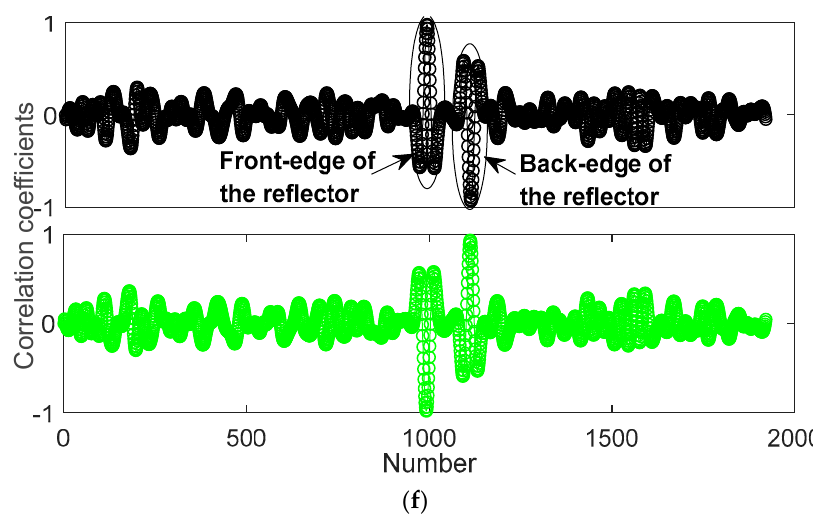
( f ) Figure 8. Numerical signals with different signal-to noise ratios (SNRs) and comparisons of the Figure 8. Numerical signals with di ff erent signal-to noise ratios (SNRs) and comparisons of the results by the proposed method and correlation coe ffi cient method; ( a ) ˆ x 1 ( t ) with SNR = 1 dB; ( b ) Distance results by the proposed method and correlation coefficient method; ( a ) 1 ˆ ( ) x t with SNR = 1 dB; curves Ψ 1 ( Up ) and Ψ 2 ( Down ) of ˆ x 1 ( t ) ; ( c ) ˆ x 2 ( t ) with SNR = 0.1 dB; ( d ) Distance curves Ψ 1 ( Up ) ( b ) Distance curves Ψ 1 ( Up ) and Ψ 2 ( Down ) of 1 ˆ ( ) x t ; ( c ) 2 ˆ ( ) x t with SNR = 0.1 dB; ( d ) Distance and Ψ 2 ( Down ) of ˆ x 2 ( t ) ; ( e ) Pearson’s correlation coe ffi cient method (PCCM) curves Ψ 1 ( Up ) and Ψ 2 curves Ψ 1 ( Up )and Ψ 2 ( Down ) of 2 ˆ ( ) x t ; ( e ) Pearson’s correlation coefficient method (PCCM) ( Down ) of ˆ x 1 ( t ) ; ( f ) PCCM curves Ψ 1 ( Up ) and Ψ 2 ( Down ) of ˆ x 2 ( t ) . curves Ψ 1 ( Up )and Ψ 2 ( Down ) of 1 ˆ ( ) x t ; ( f ) PCCM curves Ψ 1 ( Up )and Ψ 2 ( Down ) of 2 ˆ ( ) x t .